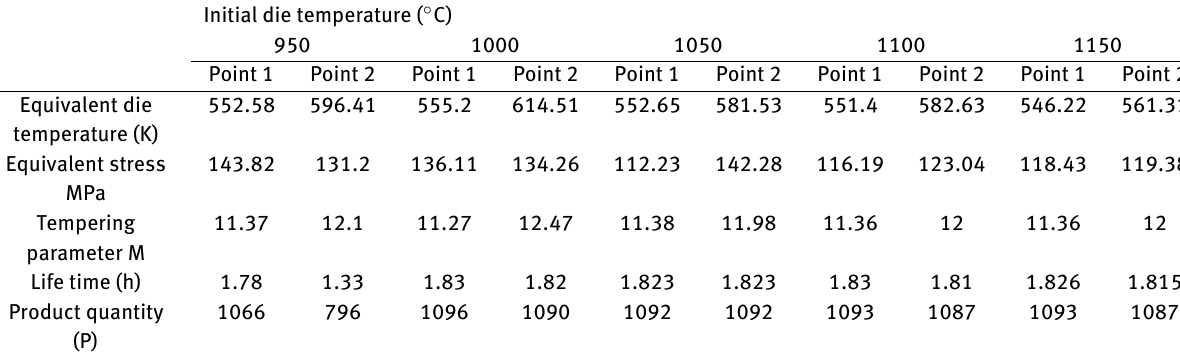
Table 2: Lower die service life in terms of plastic deformation